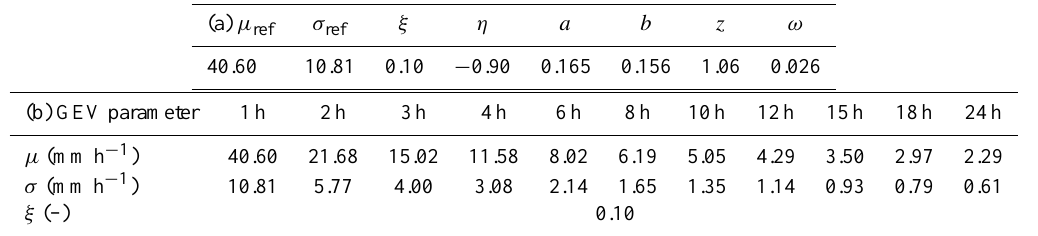
Figure 4. Example of IDAF model inference at the Niamey Aéroport rain gauge: (a) checking of the temporal simple-scaling conditions (left: linear relationship between the logarithm of the statistical moments of order q and the durations D , right: linear relationship between k(q) and q ) and estimation of the temporal simple-scaling exponent; (b) left: empirical cumulative distribution of annual maxima, right: global fitting of the GEV parameters; (c) comparison between empirical and modelled ARF. Table 1. Obtained parameters for the global IDAF model (a) and corresponding GEV parameter values for the different durations D for the point scale A =0